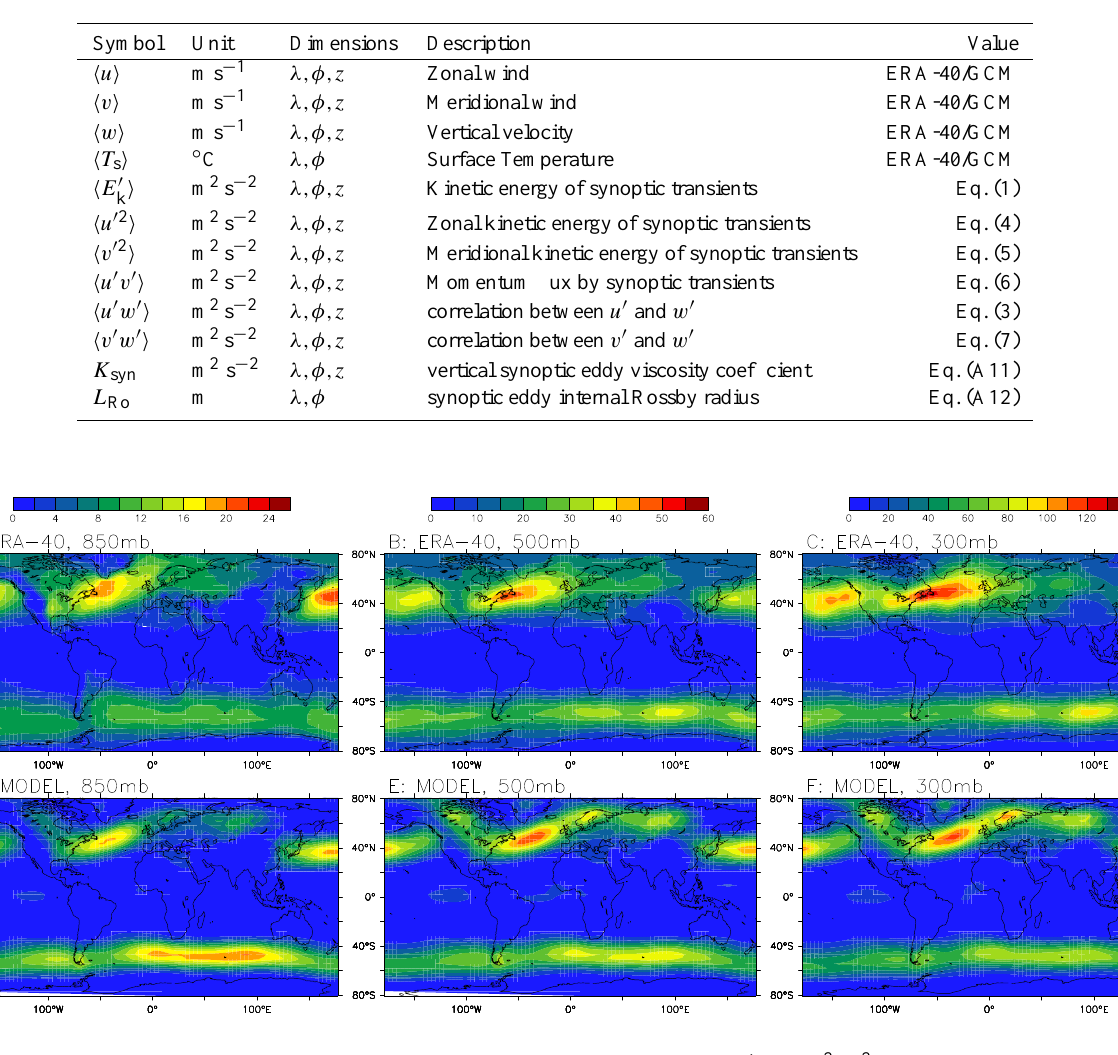
Fig. 2. Band-pass filtered ERA-40 data at (a) 850mb, (b) 500mb and (c) 300mb of h E 0 (d–f) show the results from Aeolus (Eq. 1) solutions at same pressure